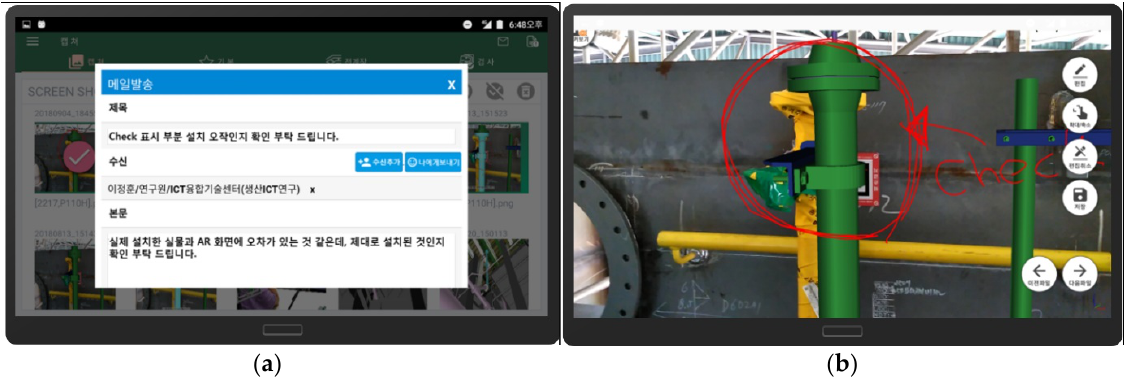
Figure 23. Effective field-oriented issue sharing using the proposed AR system. ( a ) Issue capturing and mark-up; ( b ) immediate issue sharing by